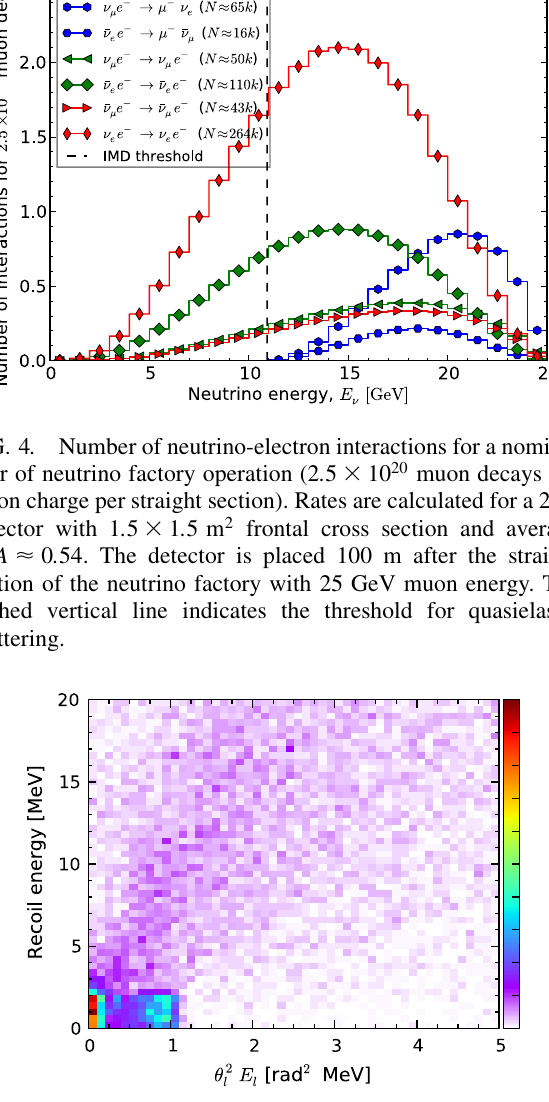
FIG. 5. True (cid:1) 2 ‘ E ‘ vs true recoil energy plus deposited energy in 1 cm of polystyrene by the scattered lepton. The peak at (cid:1) 2 ‘ E ‘ (cid:2) 0 (1) rad 2 MeV corresponds to IMD ð ES (cid:1) Þ events. A 25 GeV (cid:3) (cid:1) beam is considered.